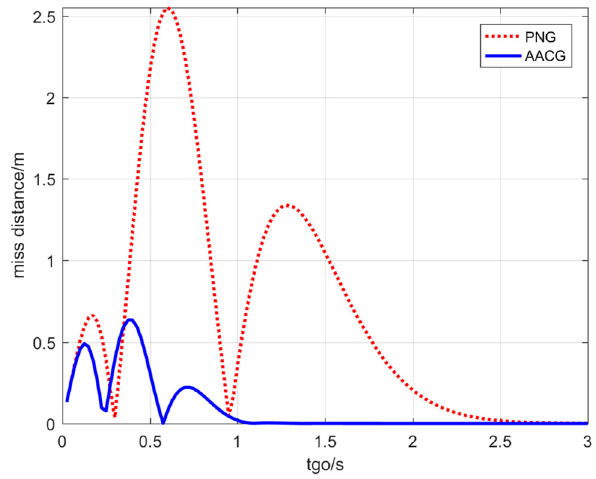
Figure 14: Aim point jumping t go – miss distance.